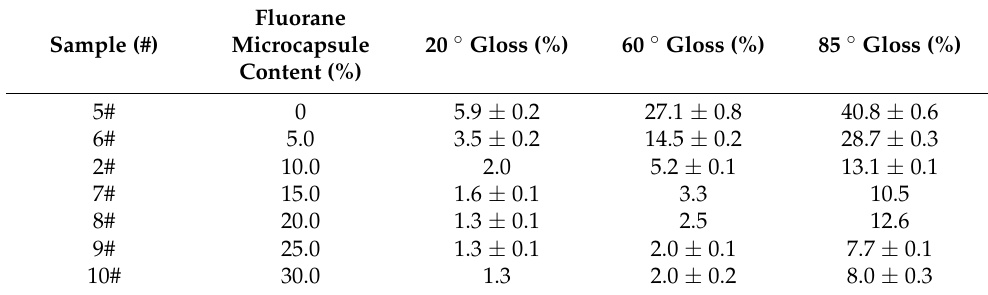
Table 6. The fluorane microcapsule content on film